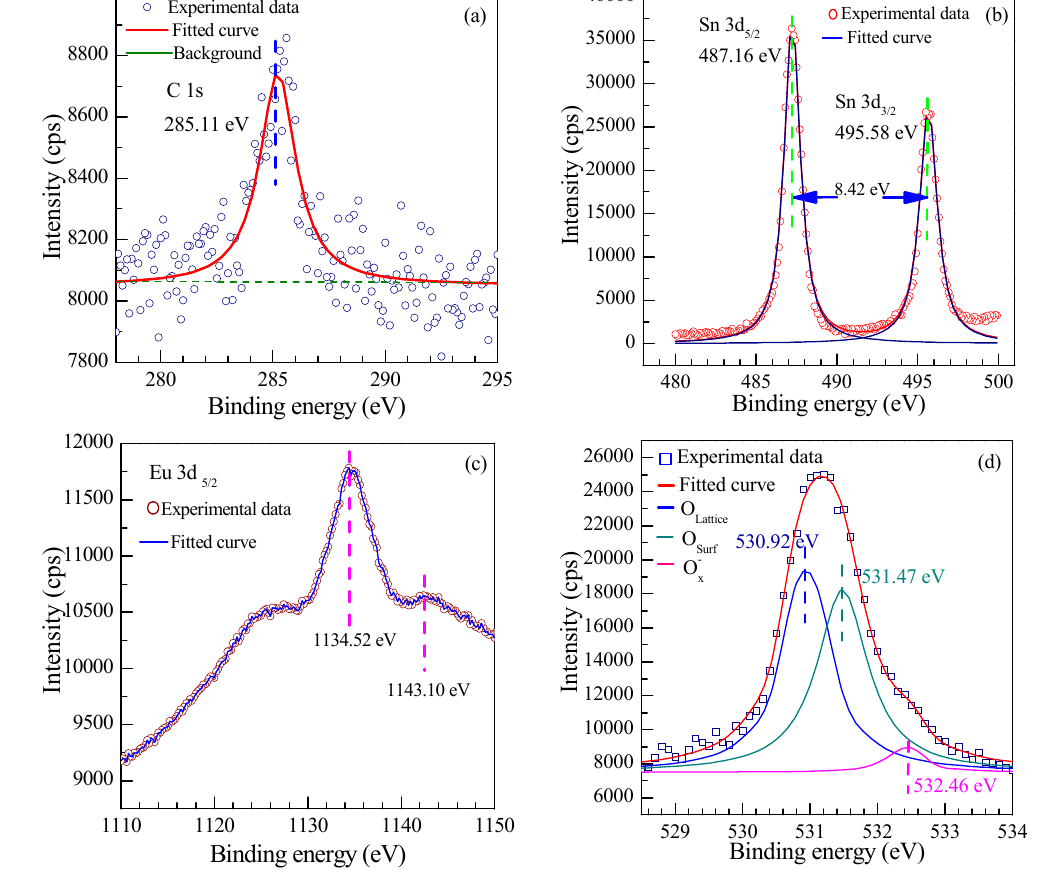
Figure 6. The High-resolution X-ray photoelectron spectroscopy (XPS) survey spectra of 0.5 at % Eu-doped SnO 2 nanorods array: ( a ) C1s; ( b ) Sn3d; ( c ) O 1s; and, ( d ) Eu 3d region.